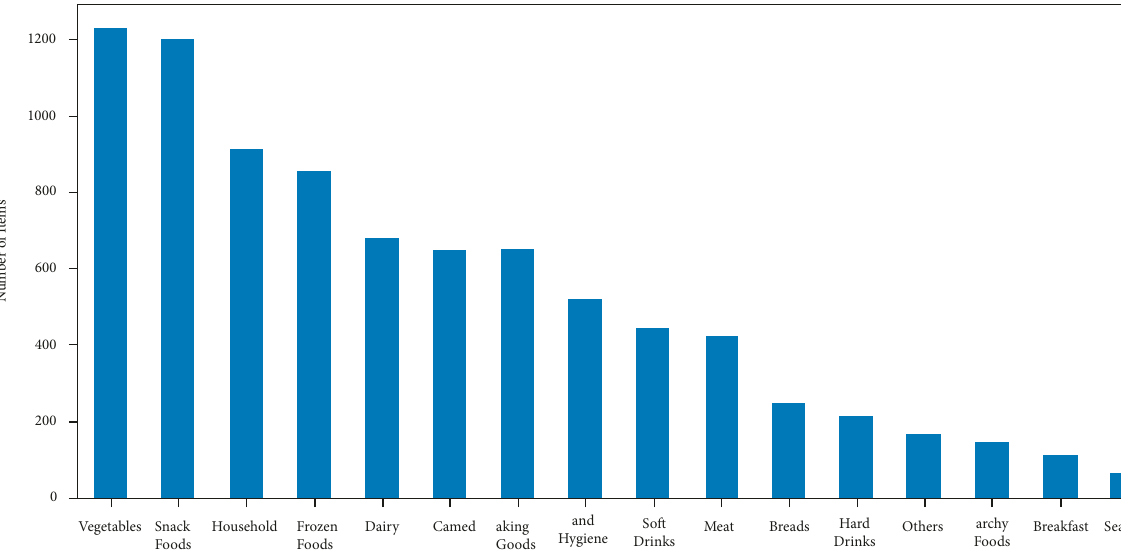
Figure 5: The number of items in different types of outlets.